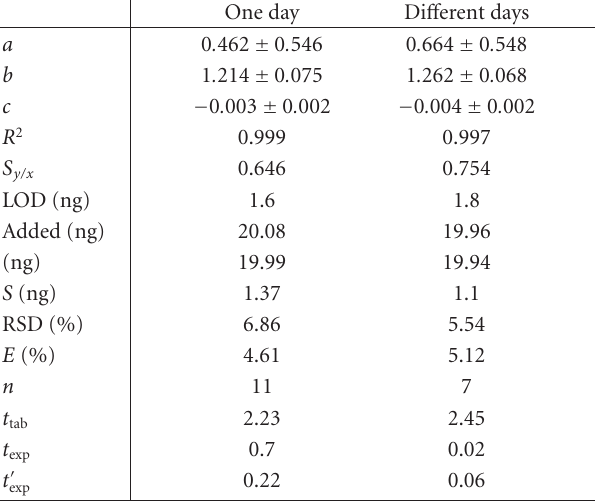
Table 2: Regression data and representative statistical parameters of the analytical